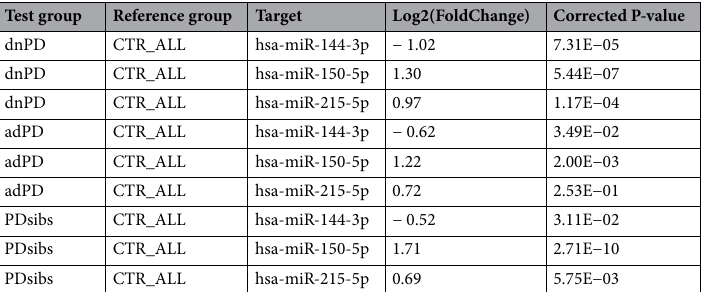
Table 4. Results of qPCR differential expression analysis on dnPD, adPD and PDsibs samples vs CTR_ALL. The table reports the Corrected P-Value and log2(FoldChange) (threshold for significance set to Corrected P-Value < 0.05 and log2(FoldChange)